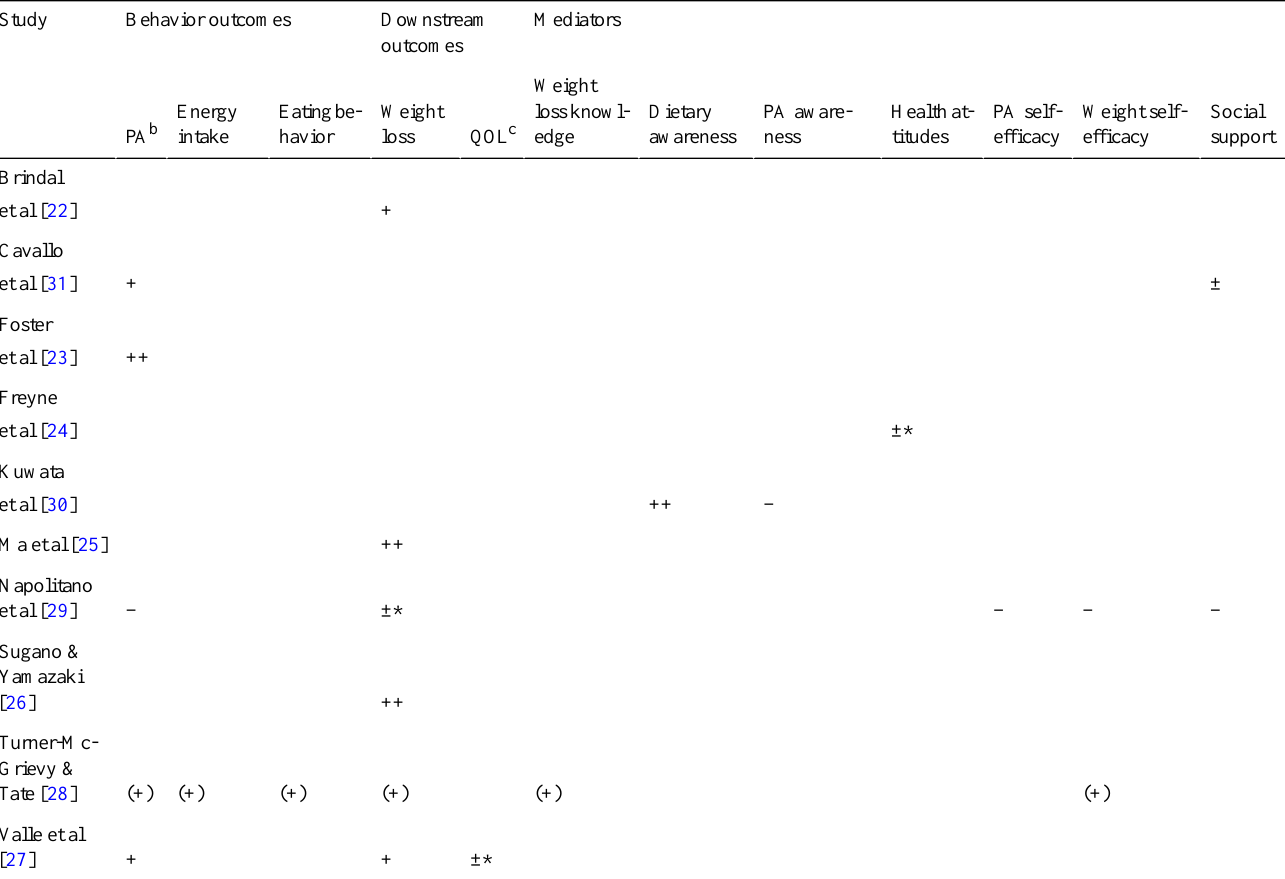
Table 2. Summary of intervention effects on behavior, downstream, and mediator outcome measures. a